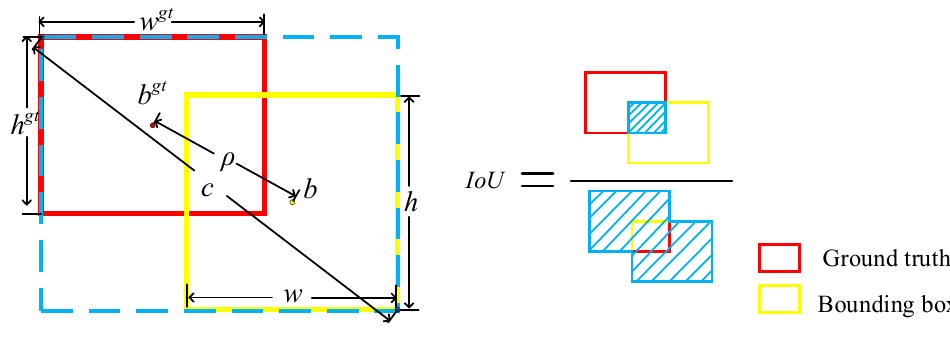
Figure 7. Parameter diagram.